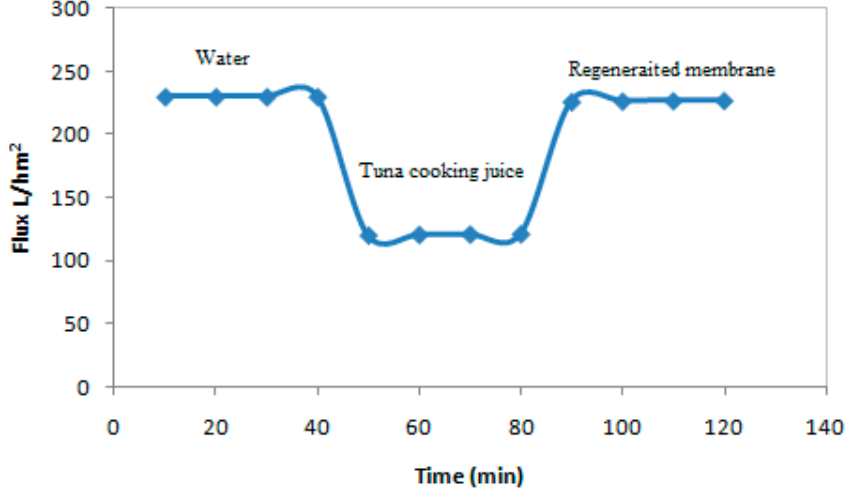
Figure 11. Recovery of membrane performance after chemical cleaning.